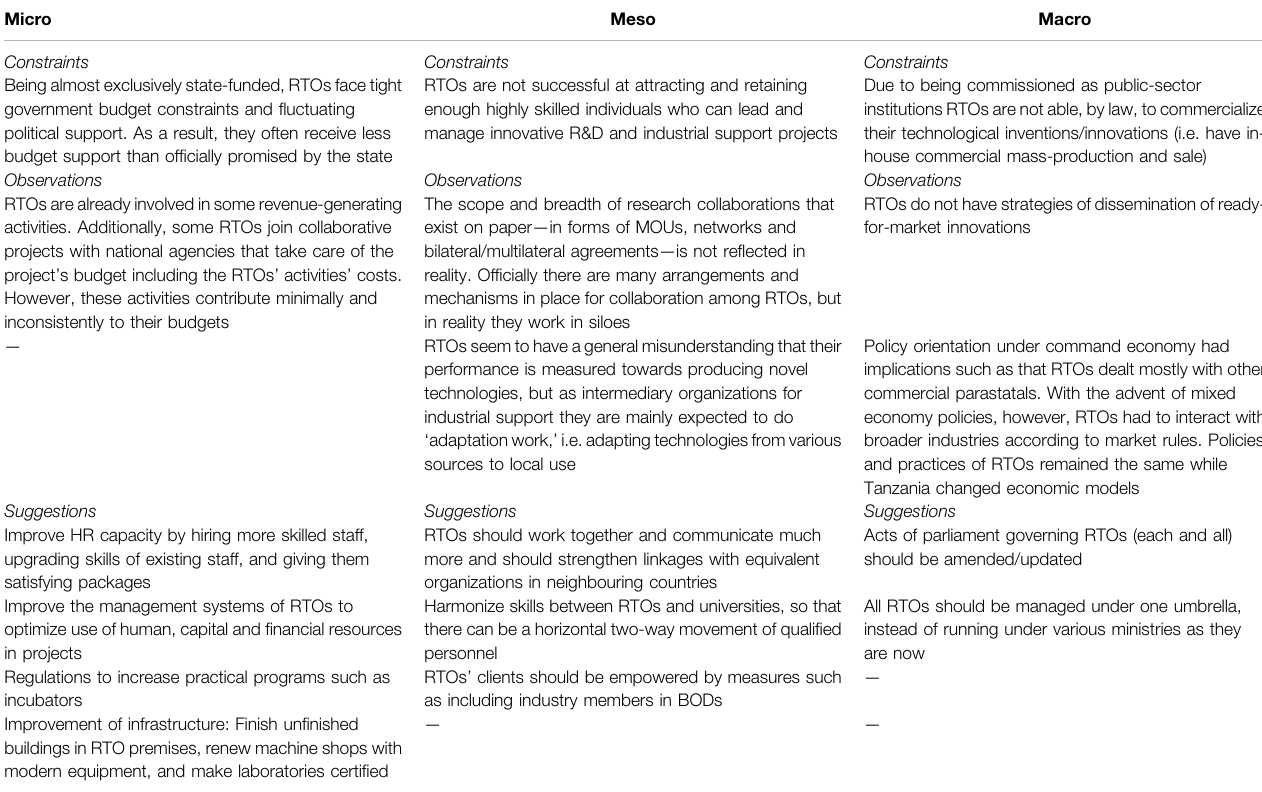
TABLE 3 | consensus statements from key informants (organized to analytical tool: multi-level policy